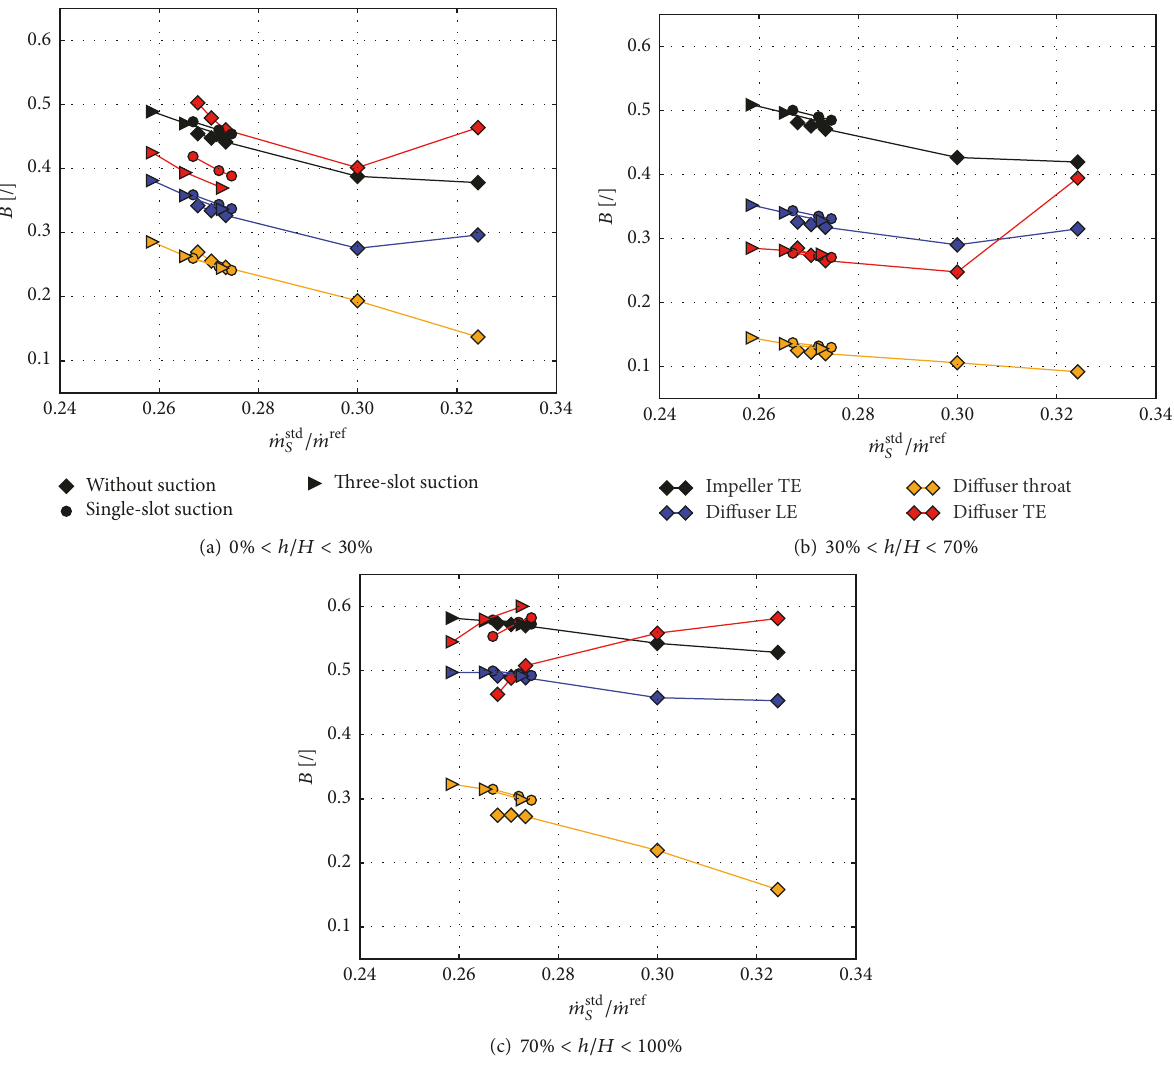
Figure 5: Blockage coefficients in the diffuser.